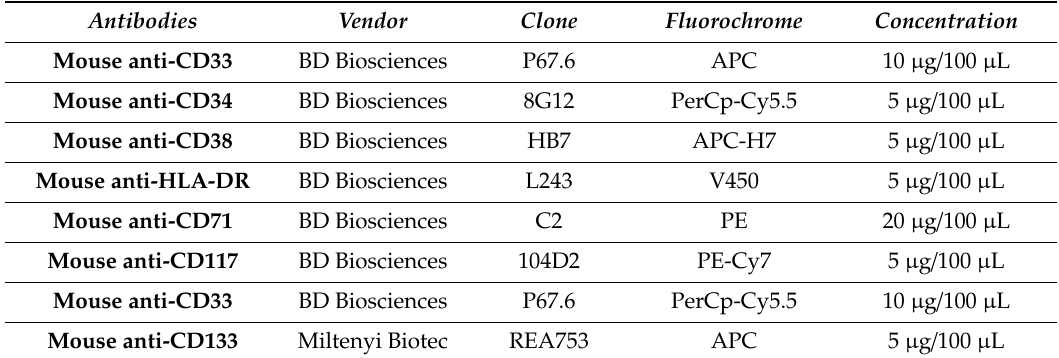
Table 4. List of antibodies for haematopoietic stem precursor cells (HSPCs) immunophenotyping. Antibodies Vendor Clone Fluorochrome Concentration Mouse anti-CD33 BD Biosciences P67.6 APC 8G12